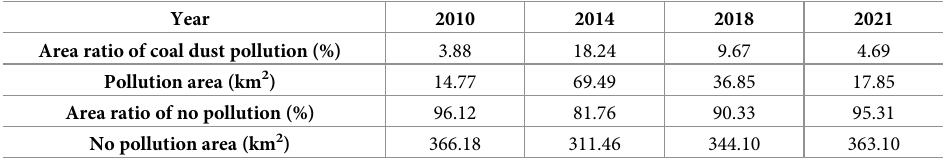
Table 2. Statistics of coal dust pollution